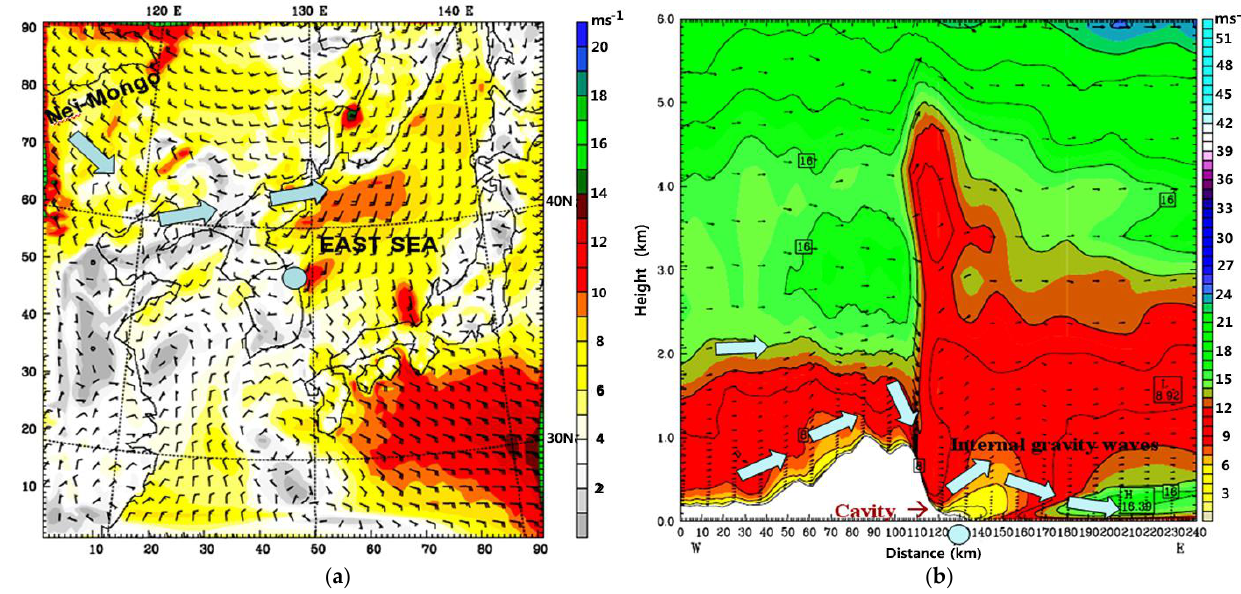
Figure 9. As shown in Figure 6, except for 21:00 LST, 29 March 2004. Southwesterly moderate wind prevailed in the vicinity of Gangneung city in ( a ) and dust emitted from the ground surface of the city merged inside a smaller calm cavity (city) below relatively moderate internal gravity waves in ( b ), resulting in a maximum PM 10